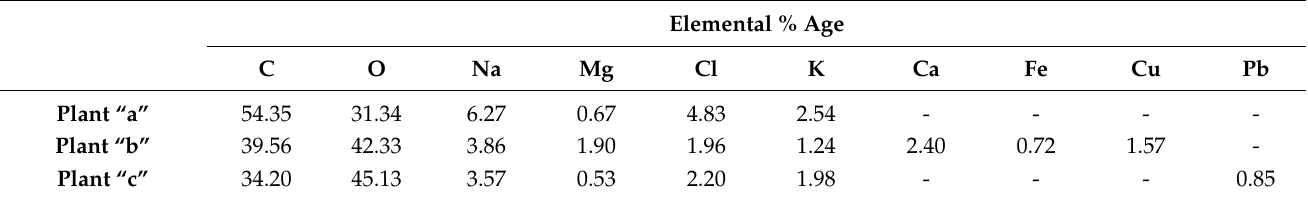
Table 3. Elemental composition of leaf surface of S. oleracea plant “a”, plants “b” and plant “c” through EDS.